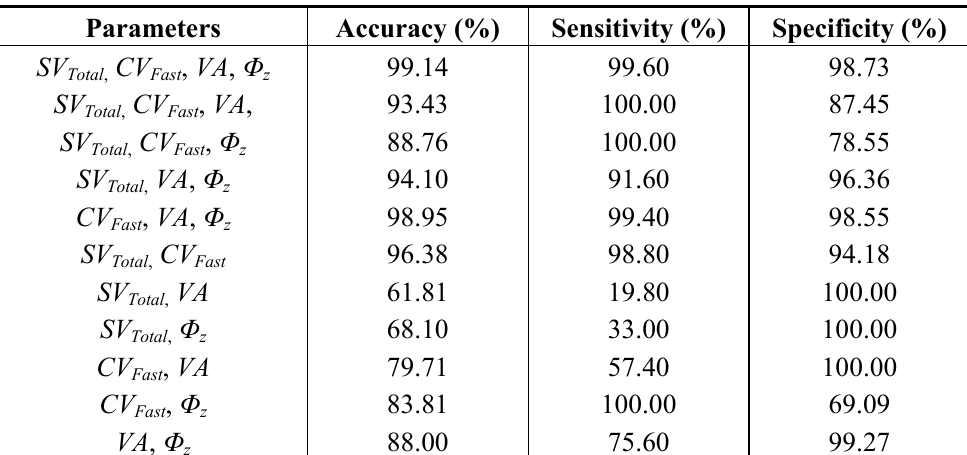
Table 3. The training results with different parameter